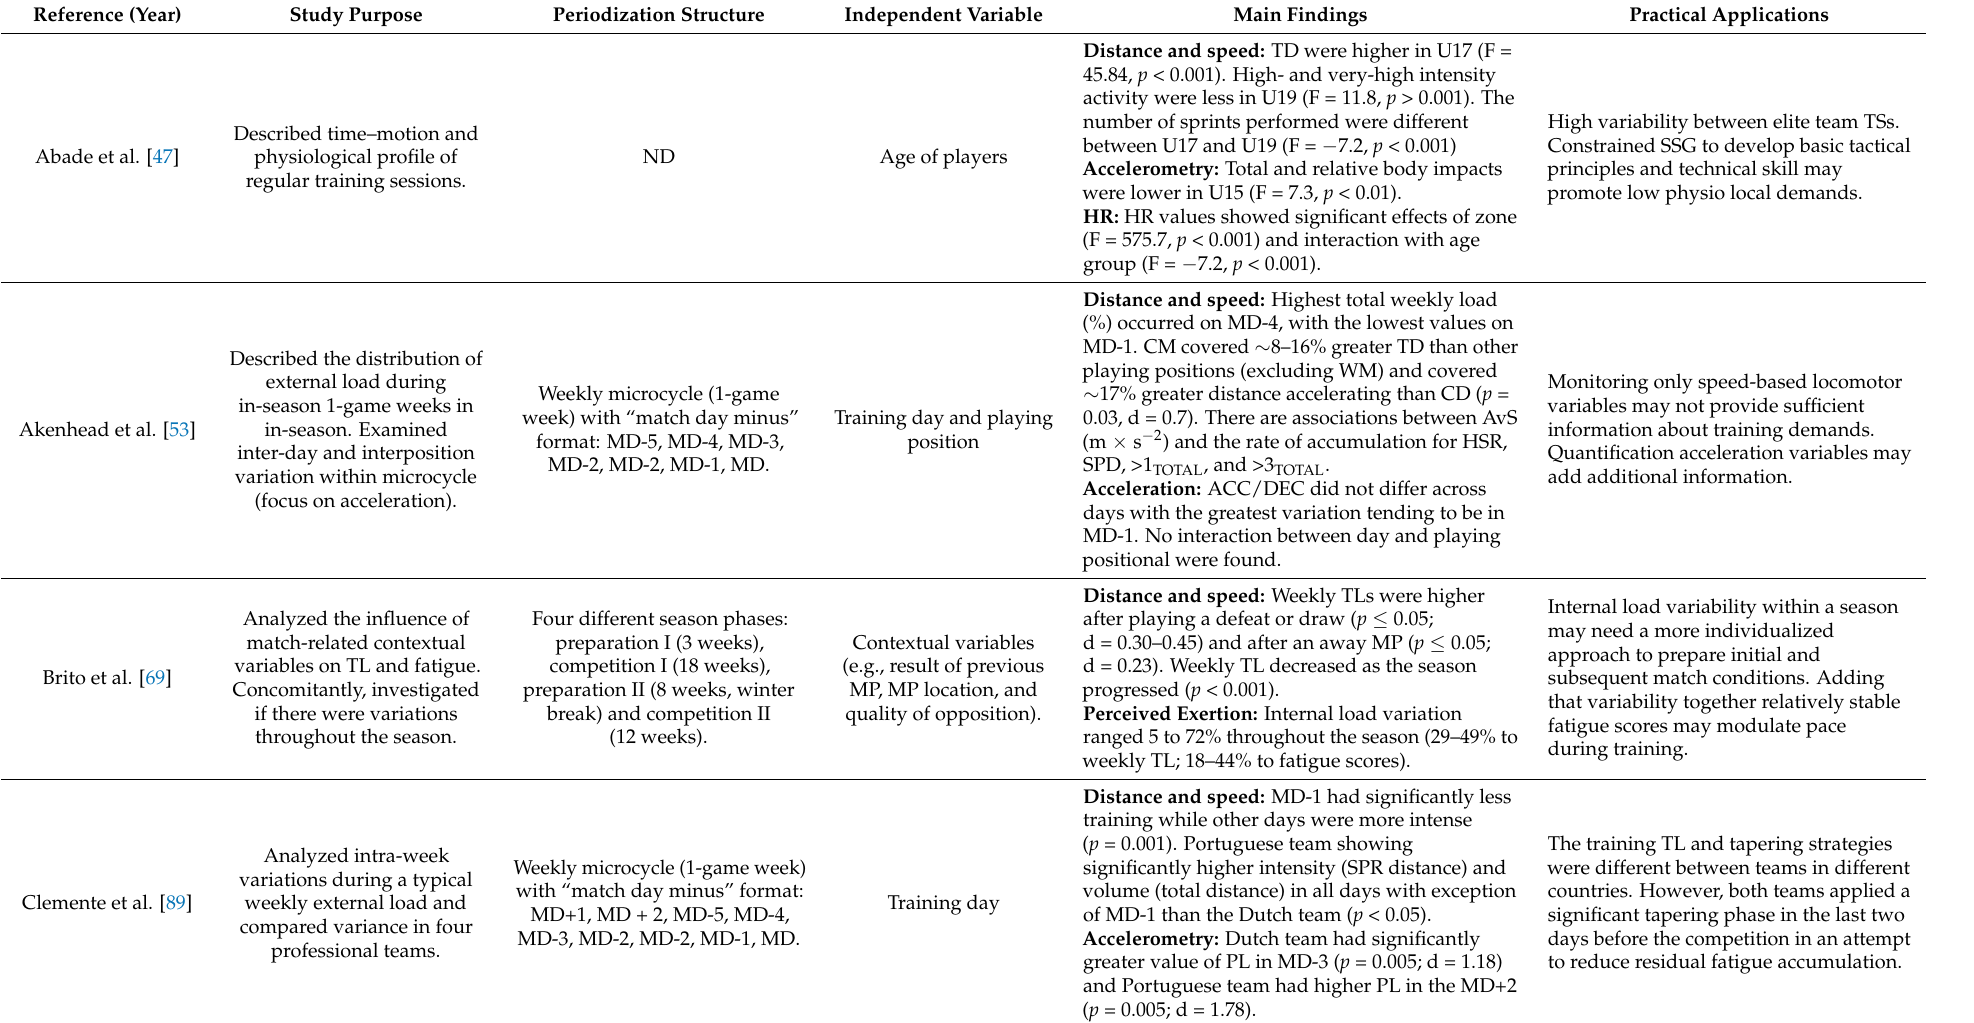
Table 5. Studies with predominantly focus on weekly training load distribution